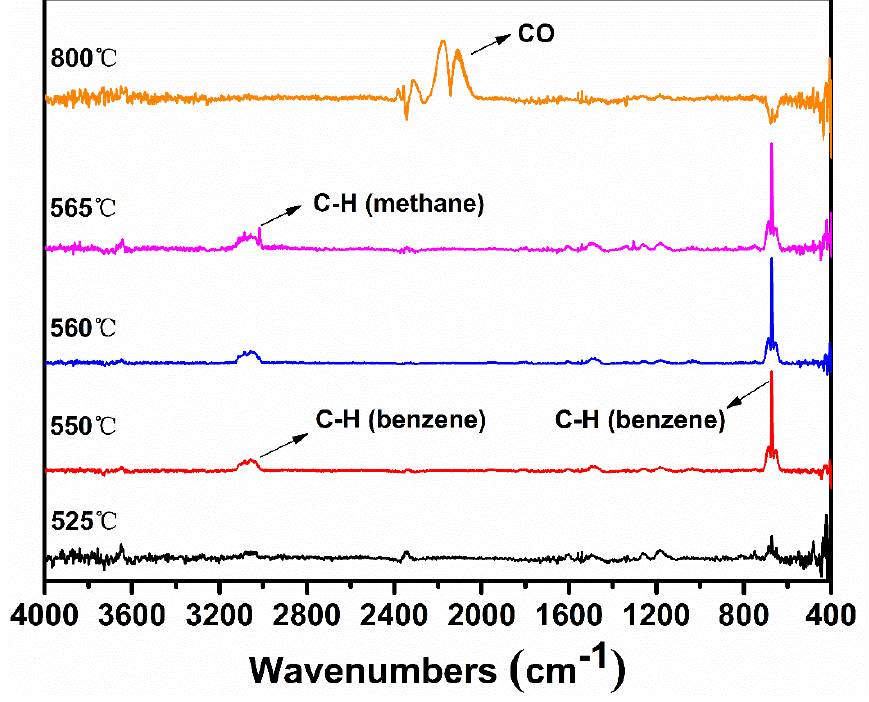
Figure 2. FTIR spectra of gaseous products of sodium phenolate at selected temperatures.